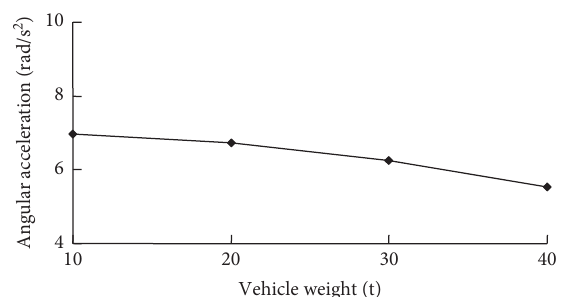
Figure 27: The variation curve of peak values of rolling vibration accelerations of the vehicle body.